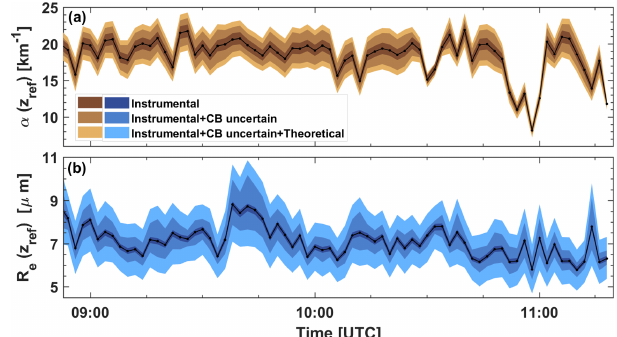
Figure 5. Contribution of the different error sources in the retrieval of the cloud extinction coefficient (a) and droplet effective radius (b) shown in Fig. 4. In (a) , the impact of instrumental uncertainties is calculated with Eq. (32) in Part 1 (Jimenez et al., 2020), the un- certainty in the cloud base (CB) determination with Eq. (34), and theoretical uncertainties with Eq. (33) in Part 1. In (b) , the impact of instrumental uncertainty is calculated with Eq. (28), the influ- ence of the CB uncertainty with Eq. (30), and theoretical uncertain- ties with Eq. (29). The uncertainty in the CB determination and the methodological (theoretical) uncertainties dominate the overall re- trieval